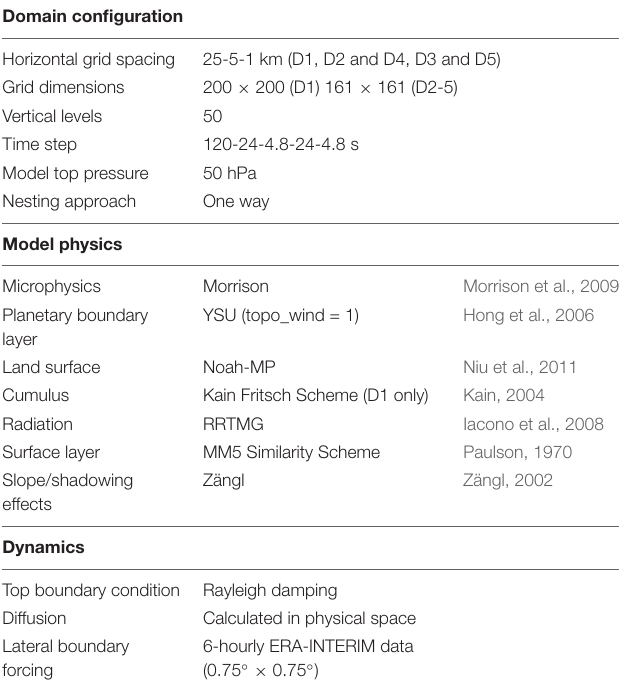
TABLE 1 | Overview WRF